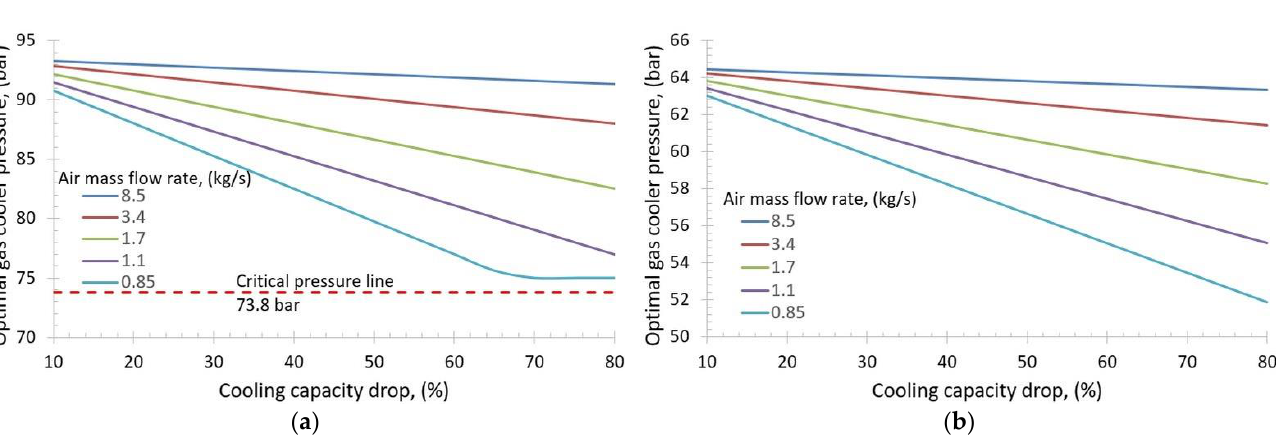
Figure 7. Optimal pressure in the gas cooler in the function of cooling capacity drop for different air mass flow rates in: ( a ) Supercritical cycle; ( b ) Subcritical cycle.